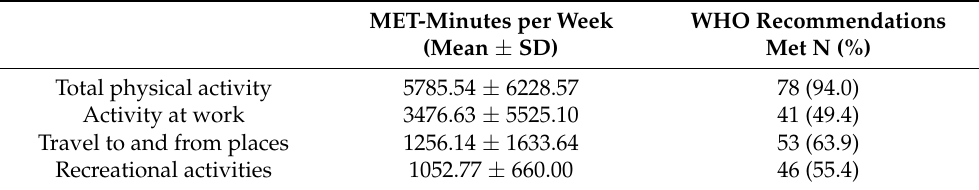
Table 2. Physical activity and percentage of Turner syndrome patients meeting WHO